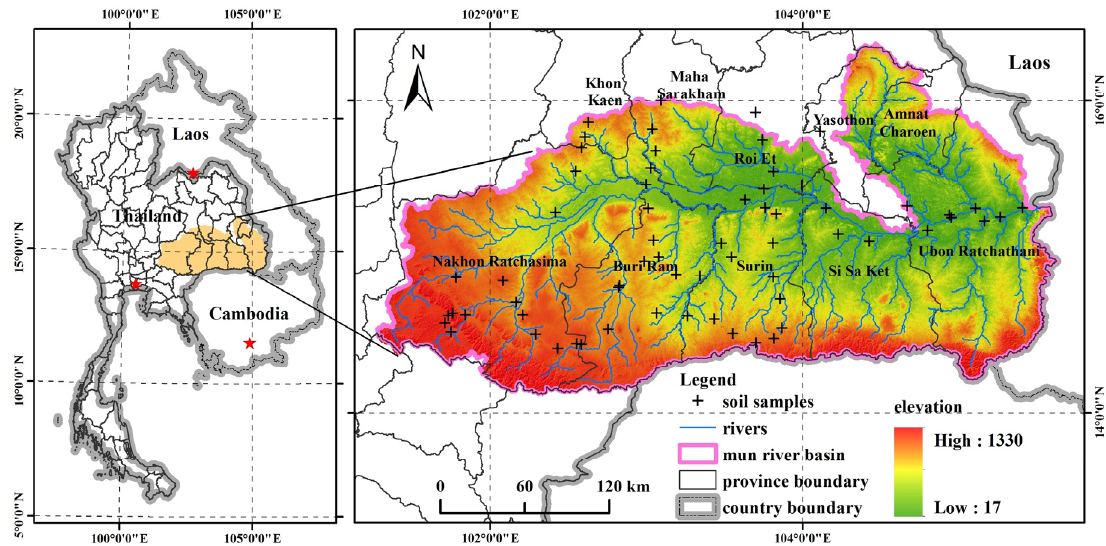
Figure 1. Scope of the study area and sampling locations.